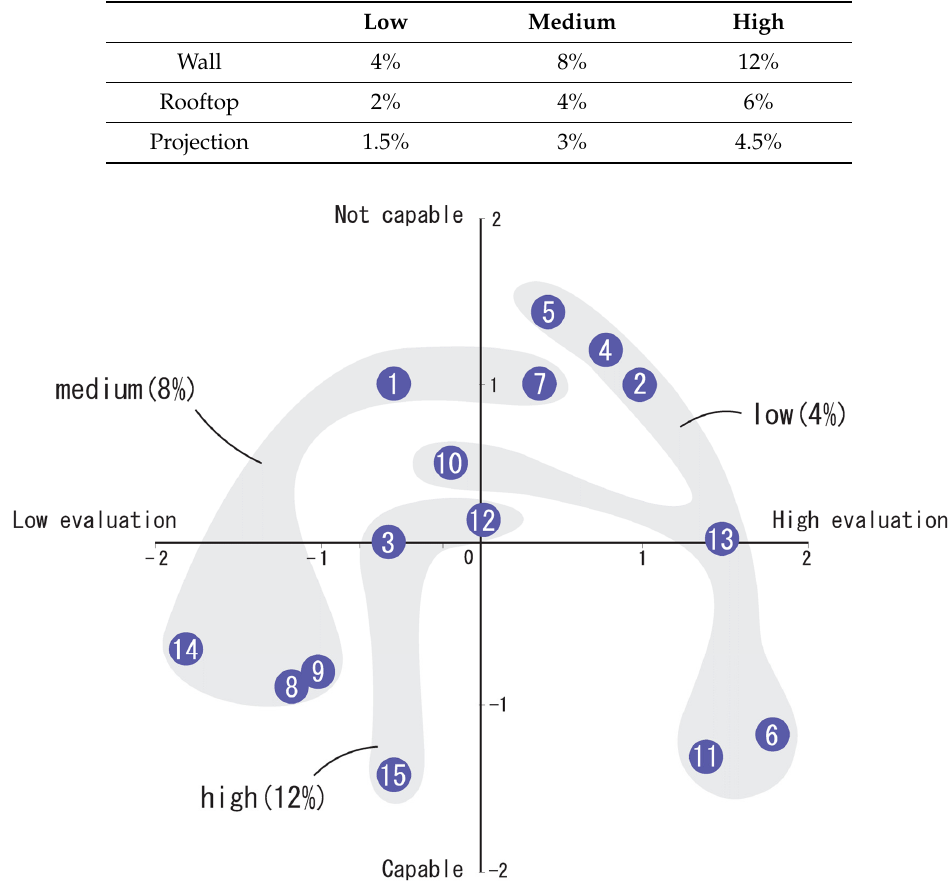
Table 11. Grouping based on proportion levels (outdoor advertising signs).